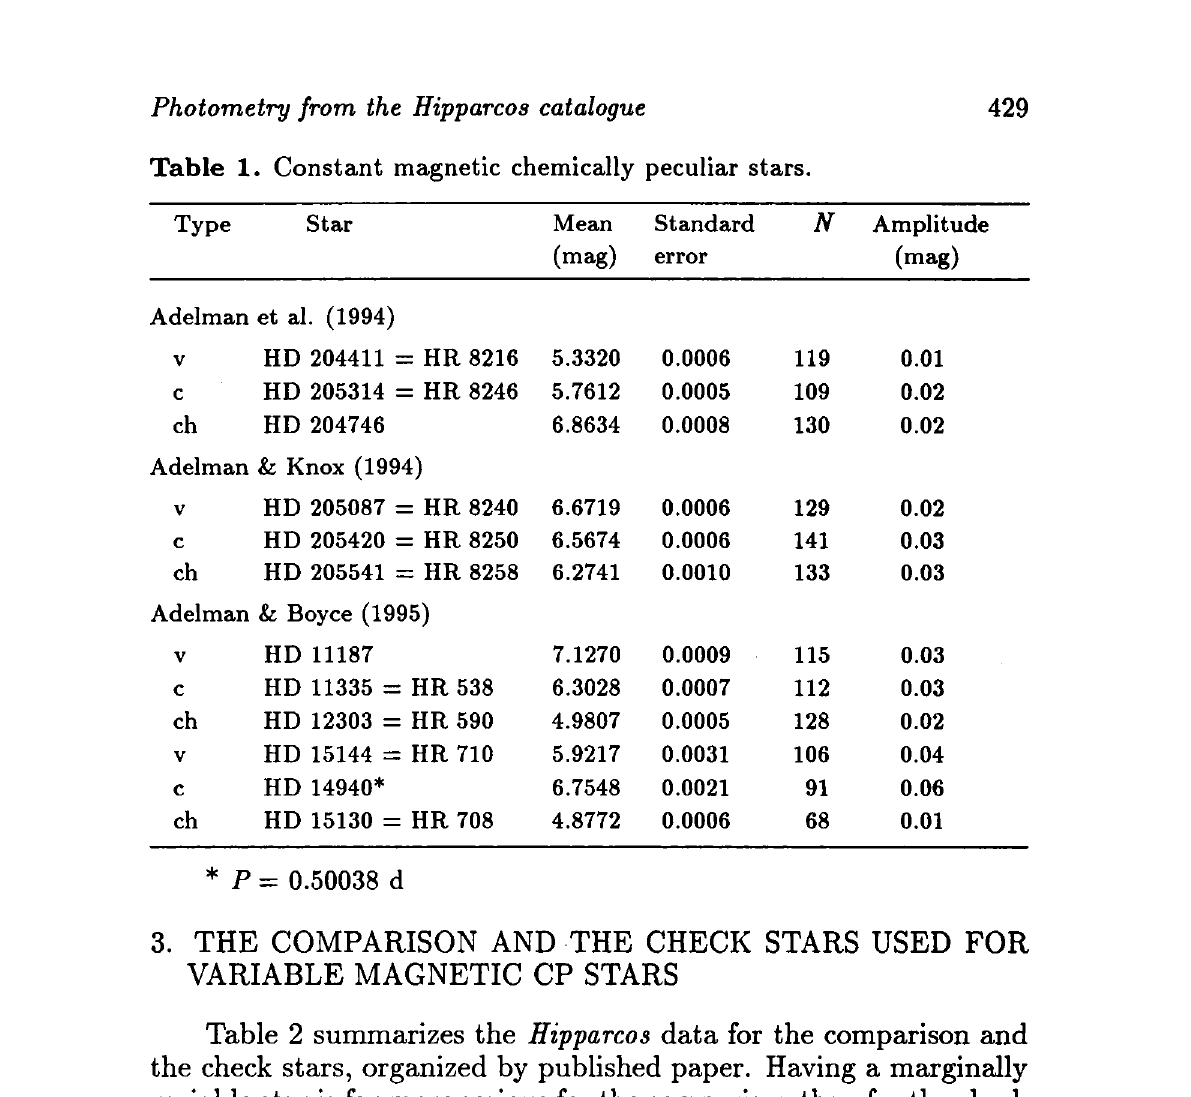
Table 1. Constant magnetic chemically peculiar